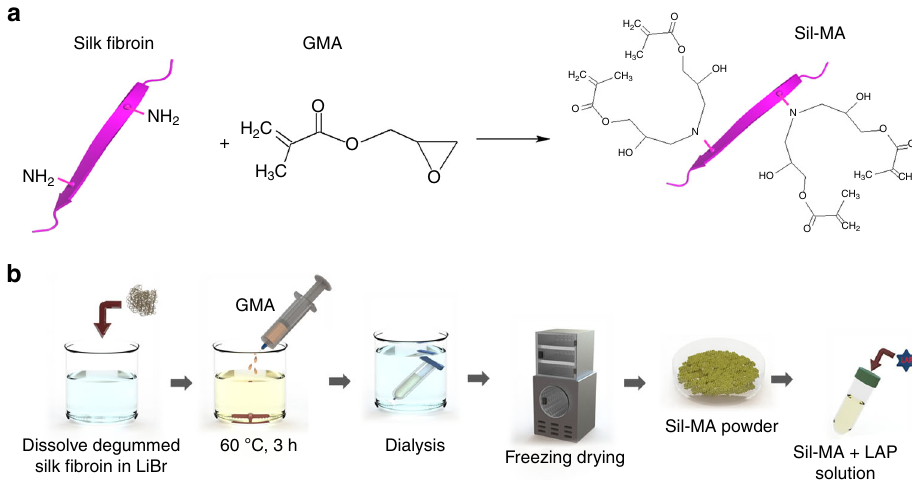
Fig. 1 Fabrication of chemically modi fi ed silk fi broin (SF) by glycidyl methacrylate (GMA) (Sil-MA) as pre-hydrogel. a Modi fi cation of SF molecule with GMA. SF is covalently immobilized with GMA, which is a donor of vinyl double bond as a UV-crosslinking site. b Schematic representation for methacrylation of SF. Degummed silk was dissolved in 9.5 M LiBr LiBr and GMA was dropped into the solution with stirring for 3 h at 60 °C. It was dialyzed to remove salts in distilled water at room temperature for 4 days and then freeze-dried. Lithium phenyl(2,4,6-trimethylbenzoyl) phosphinate (LAP) was added to GMA-modi fi ed SF